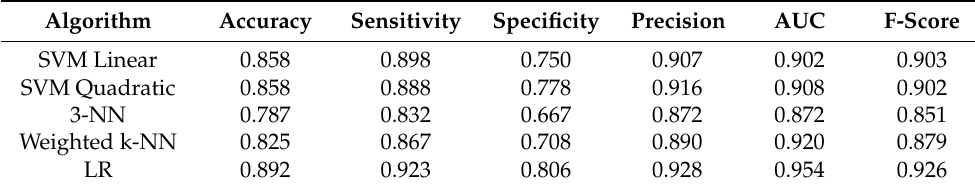
Table 4. Metrics scores for stage 1 in Model 2—binary classification.